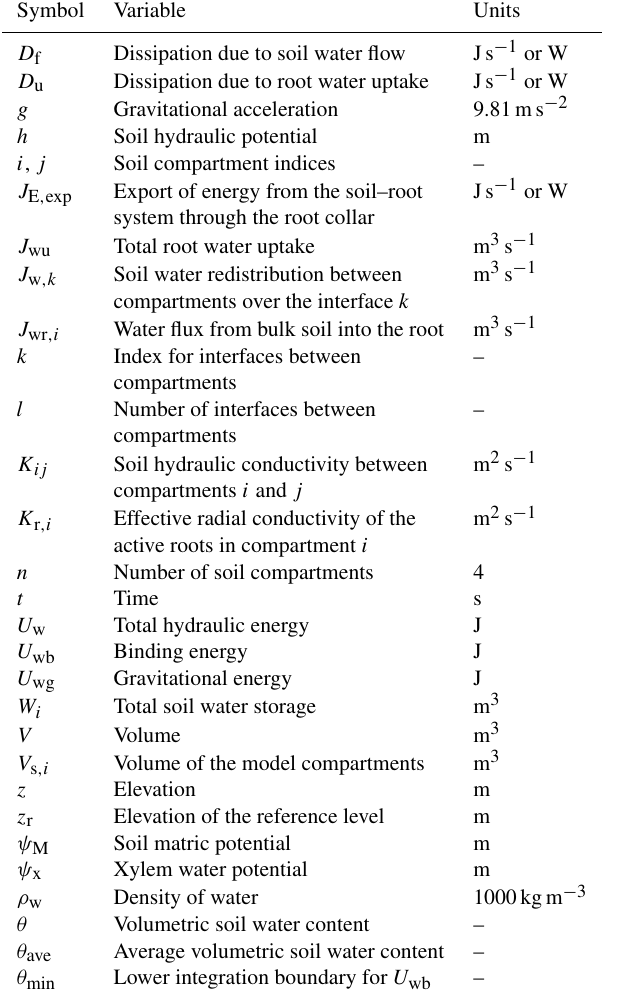
Table 2. Variables used in this study.